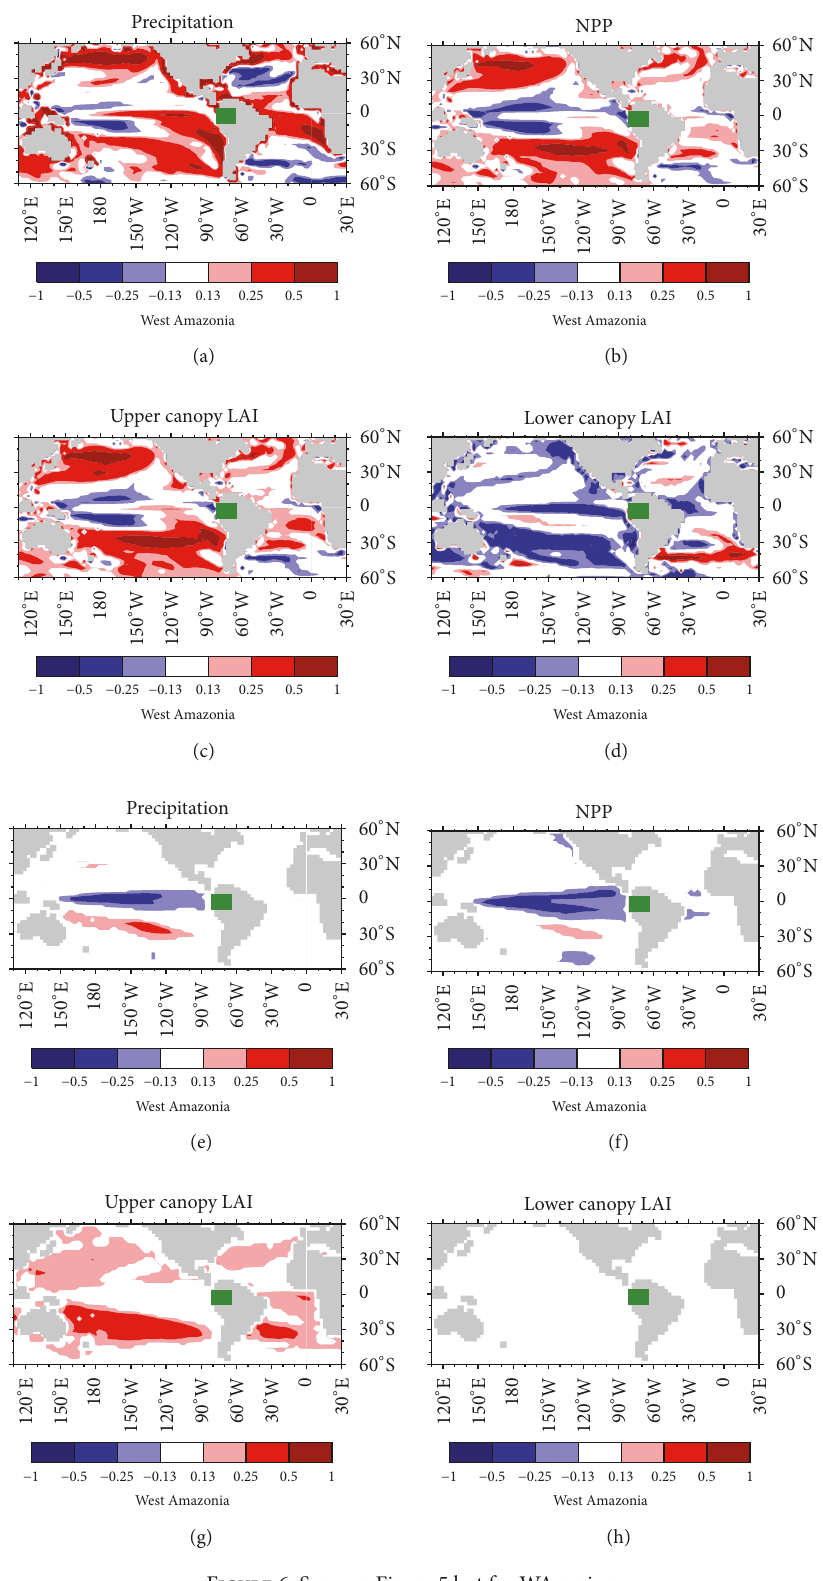
Figure 6: Same as Figure 5 but for WA